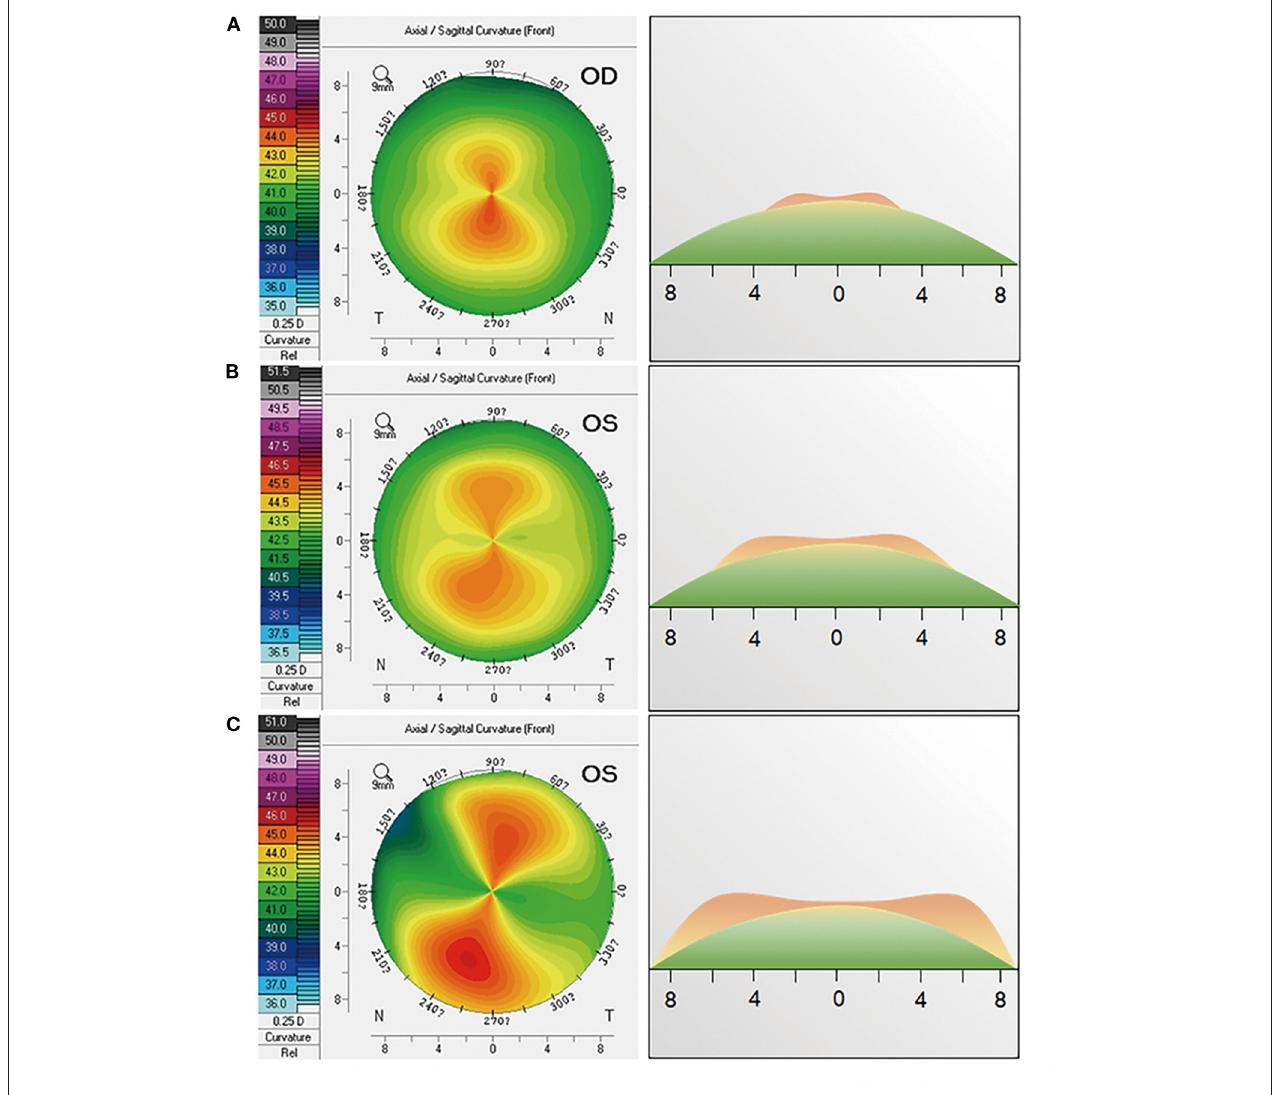
FIGURE 1 | Influences of the local corneal topography on prediction error in a symmetric bowtie. The first column shows the corneal topography of (A) eyes with small bowtie (type A, diameter ≤ 5mm), (B) eyes with medium bowtie (type B, 5mm < diameter ≤ 7mm), and (C) eyes with large bowtie (type C, diameter > 7mm). The second column shows the topographic profile on the steep axis corresponding to the first